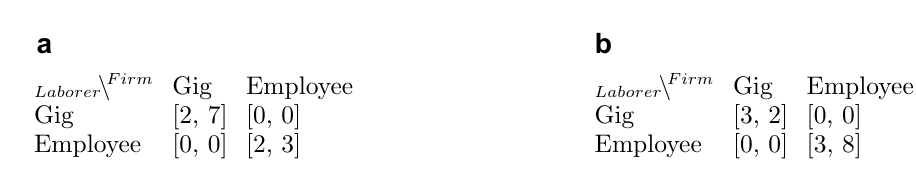
Figure A8. Payoffs for horizontal attractor arc demonstration. ( a ) Bear market, n = 0; ( b ) Bull market, n =